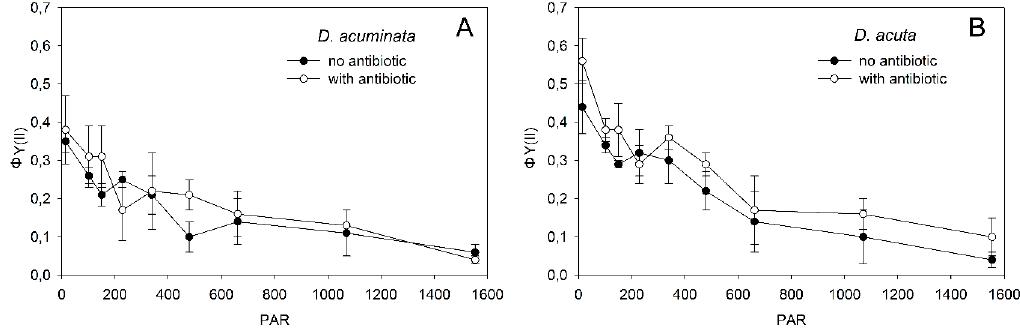
Figure 2. PAM rapid light curves (RLCs) of Φ PSII in A ) Dinophysis acuminata and B ) D. acuta triplicate cultures with (treatments) and without (controls) antibiotics with 8 different PAR conditions. Error bars represent standard deviations ( n = 3).